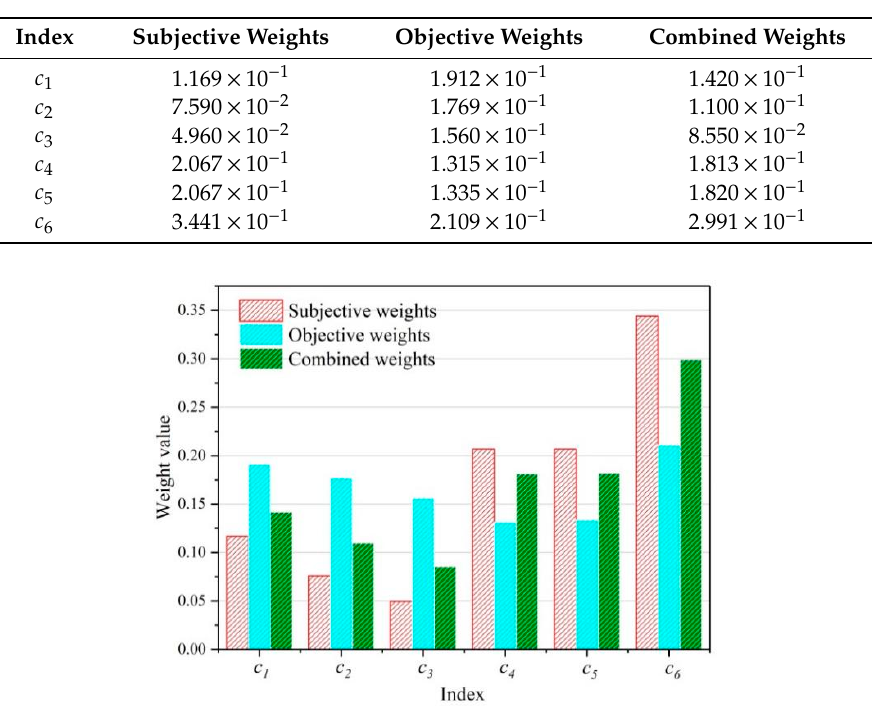
Table 3. Weight of the evaluation indices.